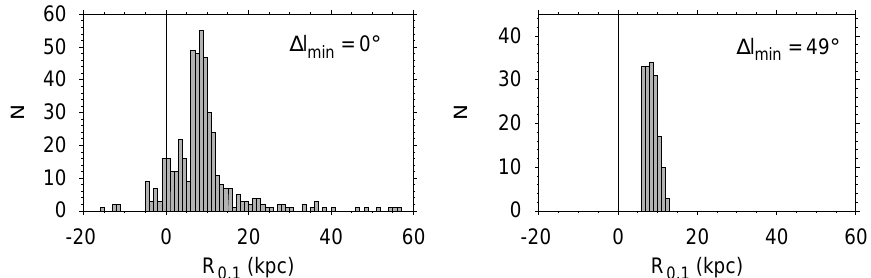
Fig. 3. Distribution of the R 0 estimates found from all possible triplets of objects belonging to the Perseus